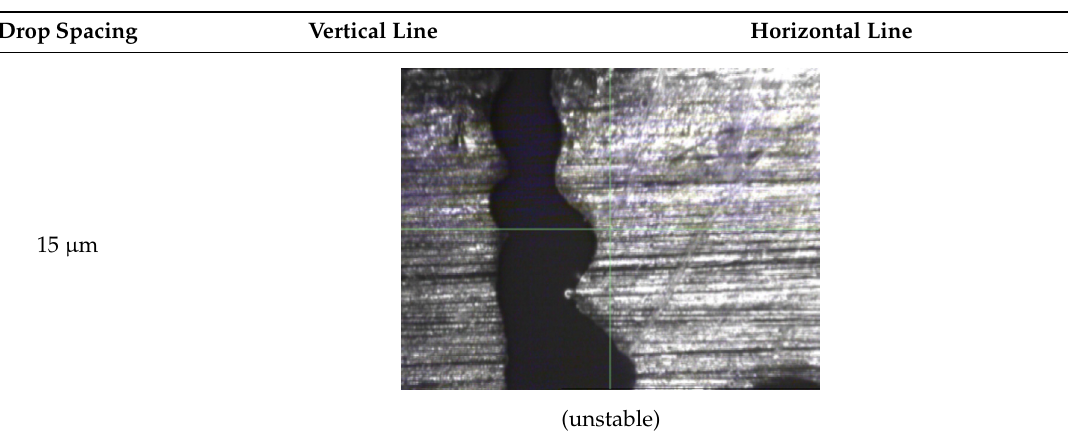
Table 1. Comparison of the fabricated vertical and horizontal line according to the different drop spacings.